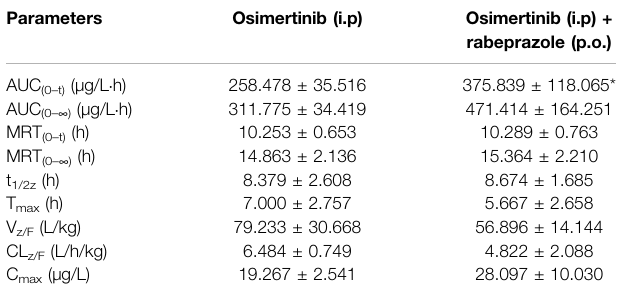
TABLE 5| Themainpharmacokineticparameters ofAZ5104intwogroupsofrats ( N = 6). Parameters Osimertinib (i.p) Osimertinib (i.p) + Rabeprazole (p.o.)